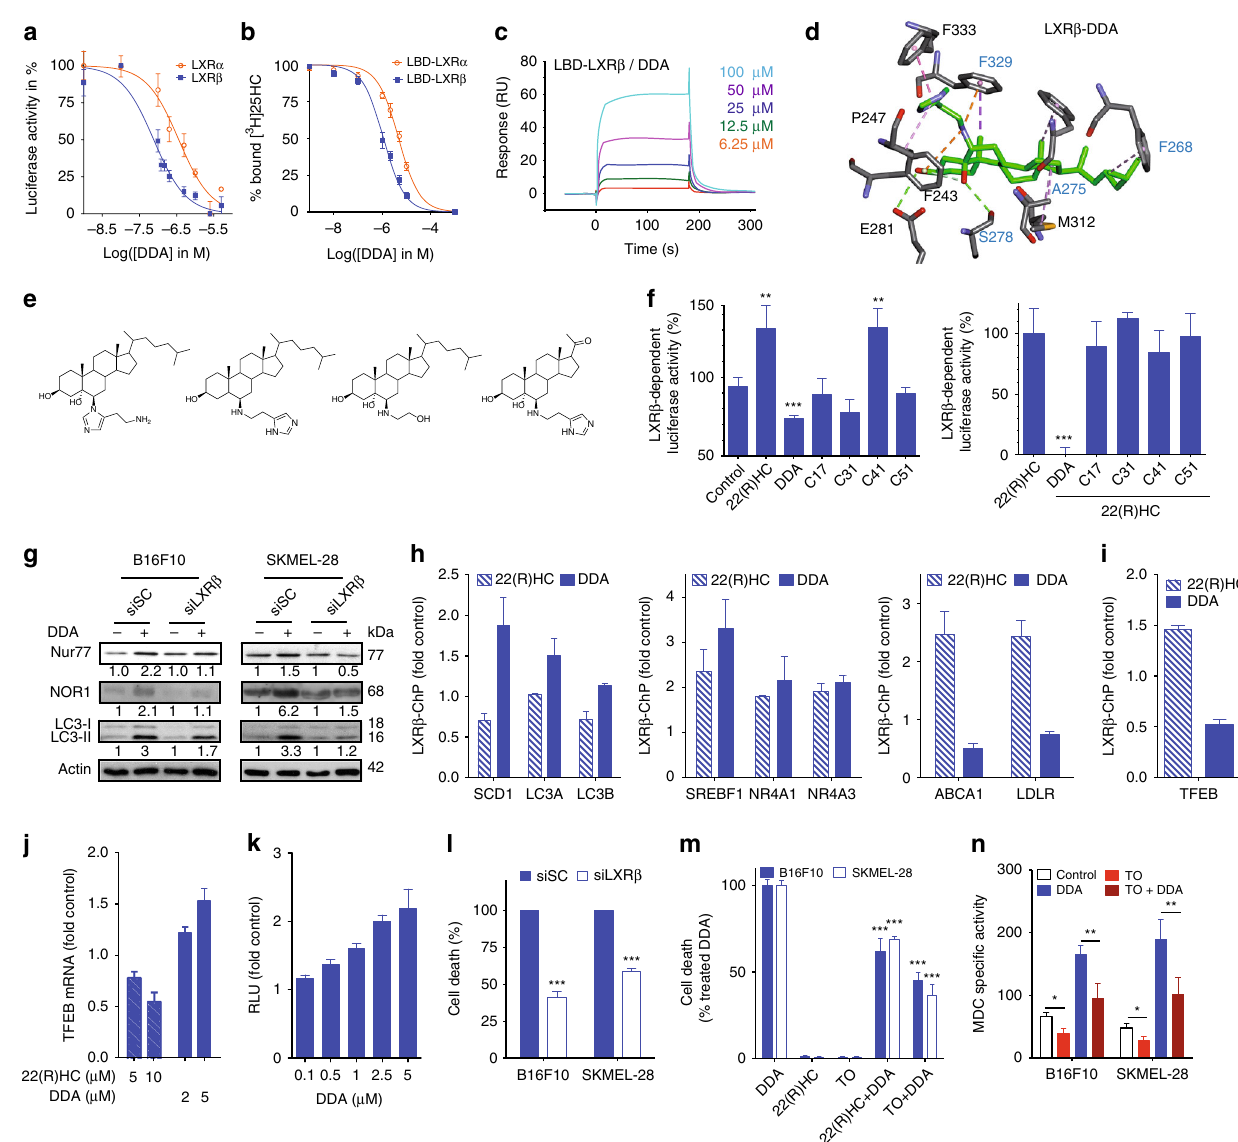
Fig. 3 LXR are targets of DDA and LXR β is required for its cytotoxicity in melanoma cells. a LXR transcriptional activity was analyzed using transient transfection reporter assays. Tranfected cells were treated with 10 µ M 22(R)HC with or without DDA. b Competition binding assays on LBD-LXR α or LBD- LXR β . c SPR sensorgrams showing the binding of DDA to the LBD-LXR β . d Molecular docking of DDA with the LBD-LXR β . Amino acid side chains that interact with DDA are represented (in black). The names of the amino acids known to interact with known LXR ligands are colored in blue. Gray: carbon atoms, white: hydrogen atoms, red: oxygen atoms, blue: nitrogen atoms, yellow: sulfur atoms. e Structures of DDA analogs assayed in the LXR reporter assay. f Analysis of LXR β -dependent agonistic or antagonistic activities by DDA and analogs. g the stimulation of LC3, Nur77, and NOR1 protein expression by DDA is LXR β -dependent. h ChIP-qPCR of LXR β on the SCD1, LC3A, LC3B, SREBP1, NR4A1, NR4A3, ABCA1, and LDLR enhancers on SKMEL-28 cells treated or not with 10 µ M 22(R)HC or 2.5 µ M DDA. i ChIP-qPCR of LXR β on the TFEB enhancer on SKMEL-28 cells treated or not with 10 µ M 22(R)HC or 2.5 µ M DDA. j Real-time PCR of TFEB expression in SKMEL-28 cells treated or not with 5 or 10 µ M 22(R)HC, and 2 or 5 µ M DDA. k Luciferase reporter gene assays with the TFEB promoter-luciferase construct in HEK293T. Cells were treated with increasing DDA concentrations. l Analysis of DDA cytotoxicity in cells transfected with control siRNA (shSC) or siLXR β . Cells were treated with 2.5 µ M DDA. m Analysis of the cytotoxicity of cells treated with or without 2 µ M DDA, 5 µ M 22(R)HC, 0.5 µ M TO, 1 µ M GW or 2 µ M DDA + 10 µ M 22(R)HC, 0.5 µ M TO, or 1 µ M GW. n TO reversed DDA induction of autophagic vesicles. Cells were treated for 24 h with or without 2 µ M DDA, 0.5 µ M TO, or 0.5 µ M TO + 2 µ M DDA. Cells were stained with MDC and observed by fl uorescence microscopy. Data from a , b , f , j , k , l , m are the means ± S.E.M. of three independent experiments performed in triplicate (* P < 0.05, ** P < 0.01, *** P < 0.001, t -test)